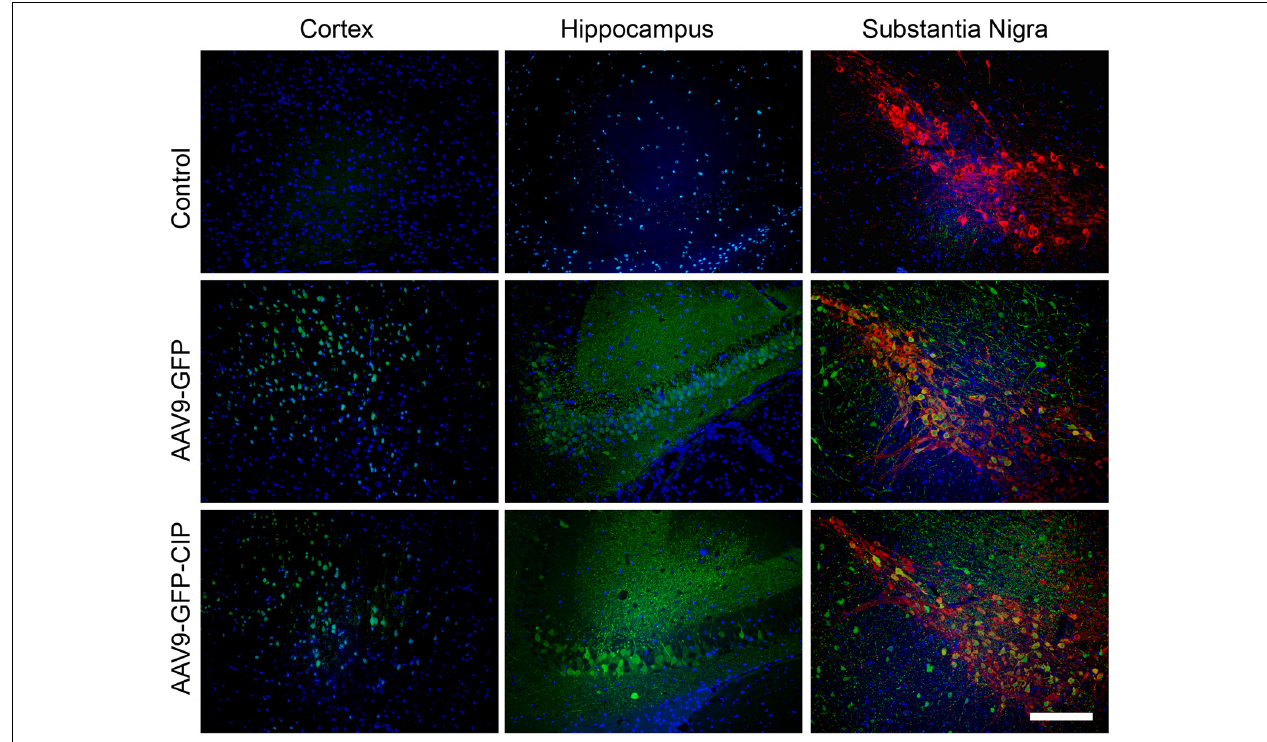
FIGURE 2 | Distribution of AAV9 vectors in brain after intracerebroventricular injection. Immunofluorescence images of cortex, hippocampus, and midbrain from mice 1 week after administration of PBS, AAV9-GFP, or AAV9-GFP-CIP. GFP was immunostained with anti-GFP and goat anti-chicken secondary antibody (Alexa Fluor R (cid:13) 488, Green). TH was immunostained with anti-TH and goat anti-rabbit secondary antibody (Alexa Fluor R (cid:13) 594, red). Nuclei were counterstained with DAPI (blue). Green fluorescence were detected in GFP group and CIP group when there is no green fluorescence in control